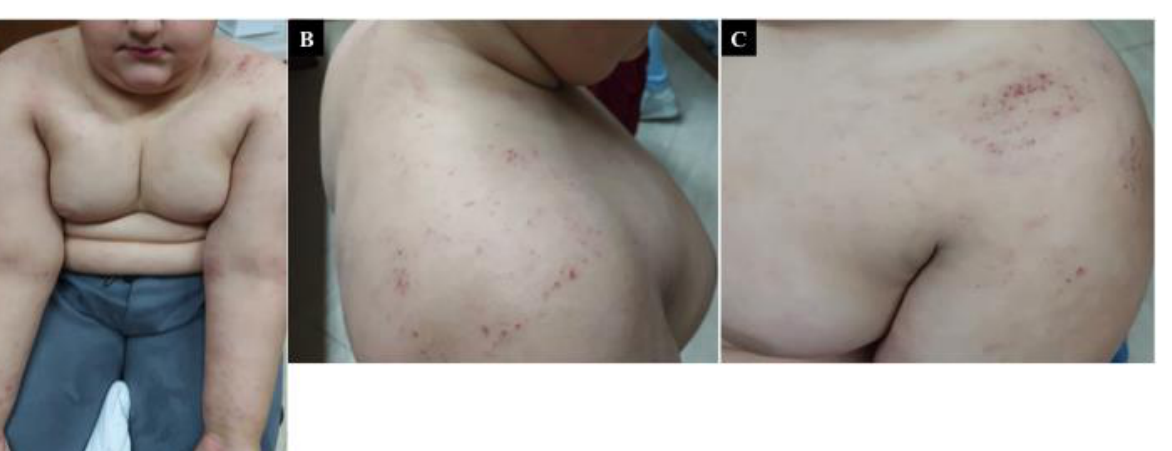
Figure 1. Dermatitis Herpetiformis. ( A ) Erythematous, papular, and vesiculosus lesions in a 14 year old child with Atopic Dermatitis and diagnosis of Celiac disease. ( B , C ) a magnification of the DH shows a typical polymorphism consisting of erythema, urticarial plaques, papules, grouped vesicles and blisters associated with intense itch and therefore followed by erosions, excoriations, and hyperpigmentation.